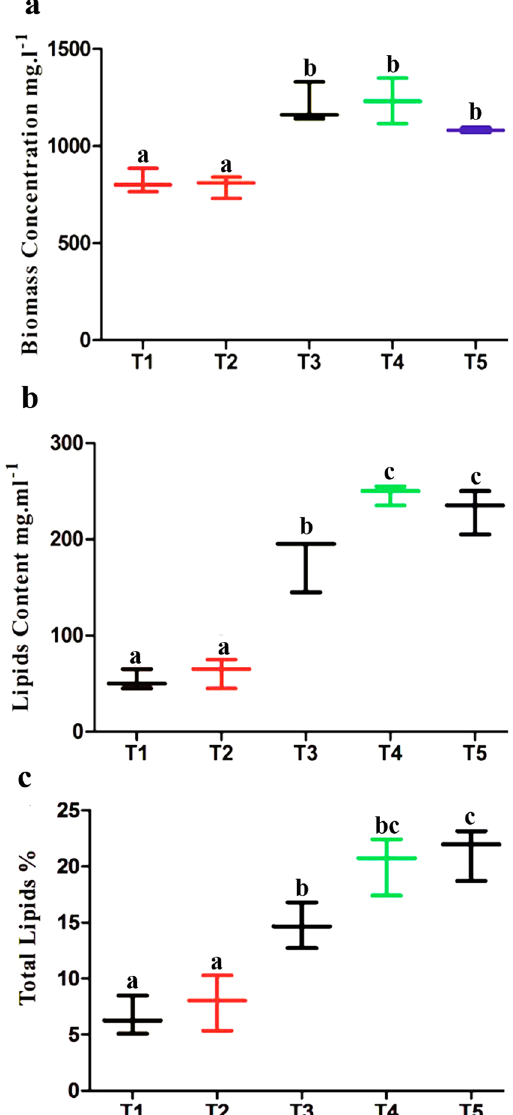
Figure 5. ( a ) Biomass of D. salina (mg L − 1 ) grown over 21 d, with five treatments (T1 to T5) in the presence of different NaCl levels (0.5, 1. 1.5. 2 and 2.5 M) respectively. ( b ) Lipid contents of D. salina (mg L − 1 ) grown over 21 d in the presence of different NaCl levels (0.5, 1. 1.5. 2 and 2.5 M). ( c) Total lipid percentage of D. salina grown over 21 d in the presence of different NaCl levels (0.5, 1. 1.5. 2 and 2.5 M). Bars represent the means of